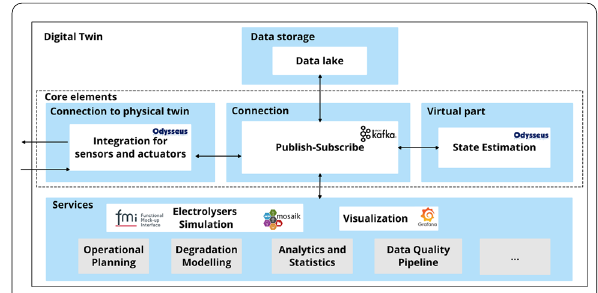
Fig. 1 Electrolysers DT architecture and technologies from the 5D DT concept point of view as in Tao et al.